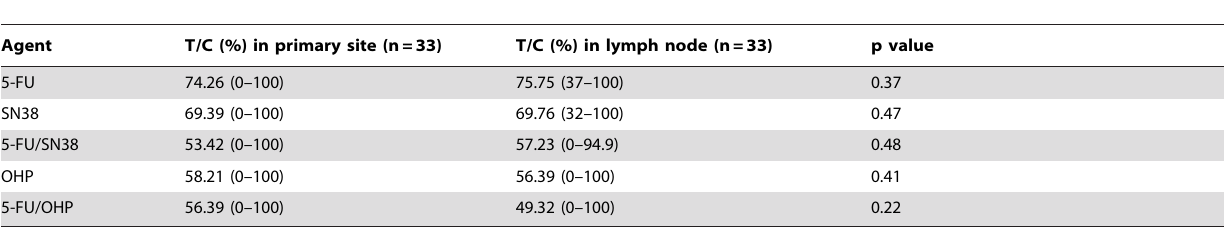
Table 3. Comparison of chemosensitivity between primary site and lymph node metastasis in CD-DST.